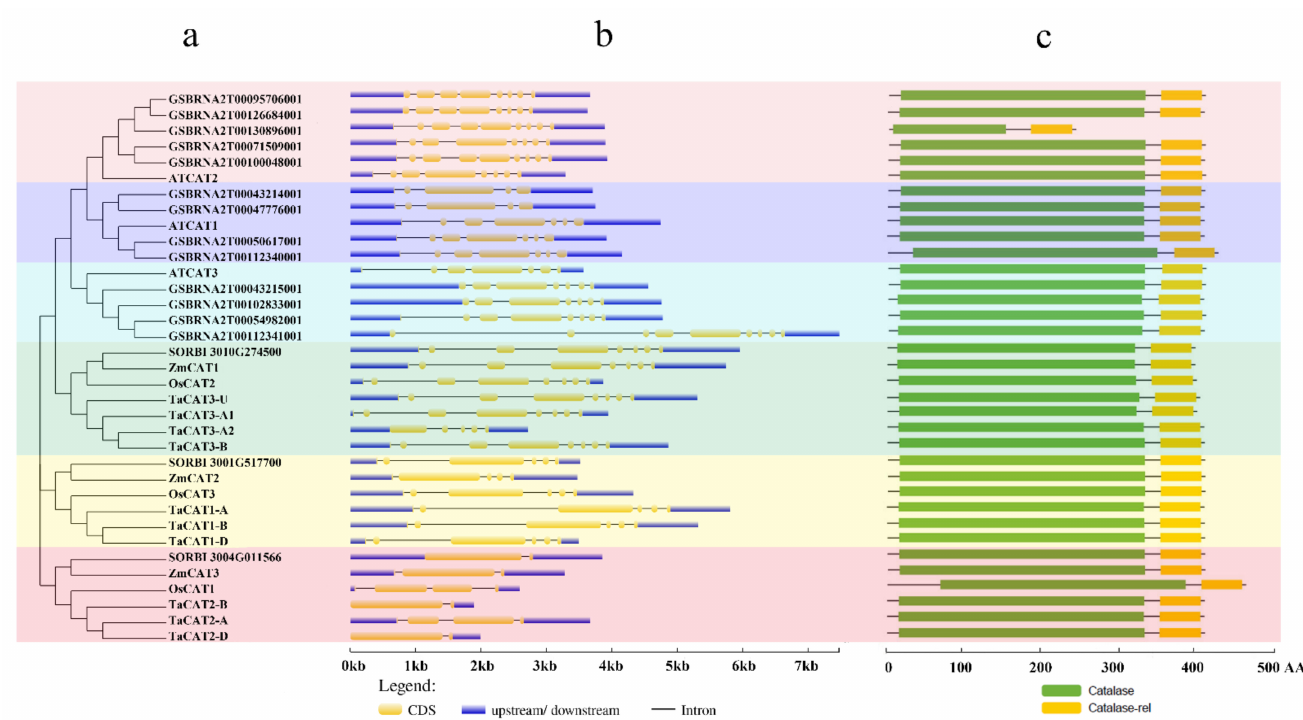
Figure 2. Phylogenetic relationships, gene structures, and conserved domains in CAT genes of Arabidopsis, B. napus , rice, sorghum, wheat, and maize. ( a ) Phylogenetic tree was constructed based on the full-length protein sequences of CAT genes using MEGA-X software with the cali- bration parameter of 1000; ( b ) exon–intron structure of CAT genes. The blue box represents the upstream/downstream sequences. The yellow boxes and the black horizontal lines represent the exons and introns, respectively; Scale indicates 1.0 kb; ( c ) schematic diagram of the conserved domain of CAT proteins. Catalase core domain (Catalase, PF00199) and catalase-related immune-responsive domain (Catalase-rel, PF06628) were shown in the blue and yellow boxes, respectively; Scale indicates 100